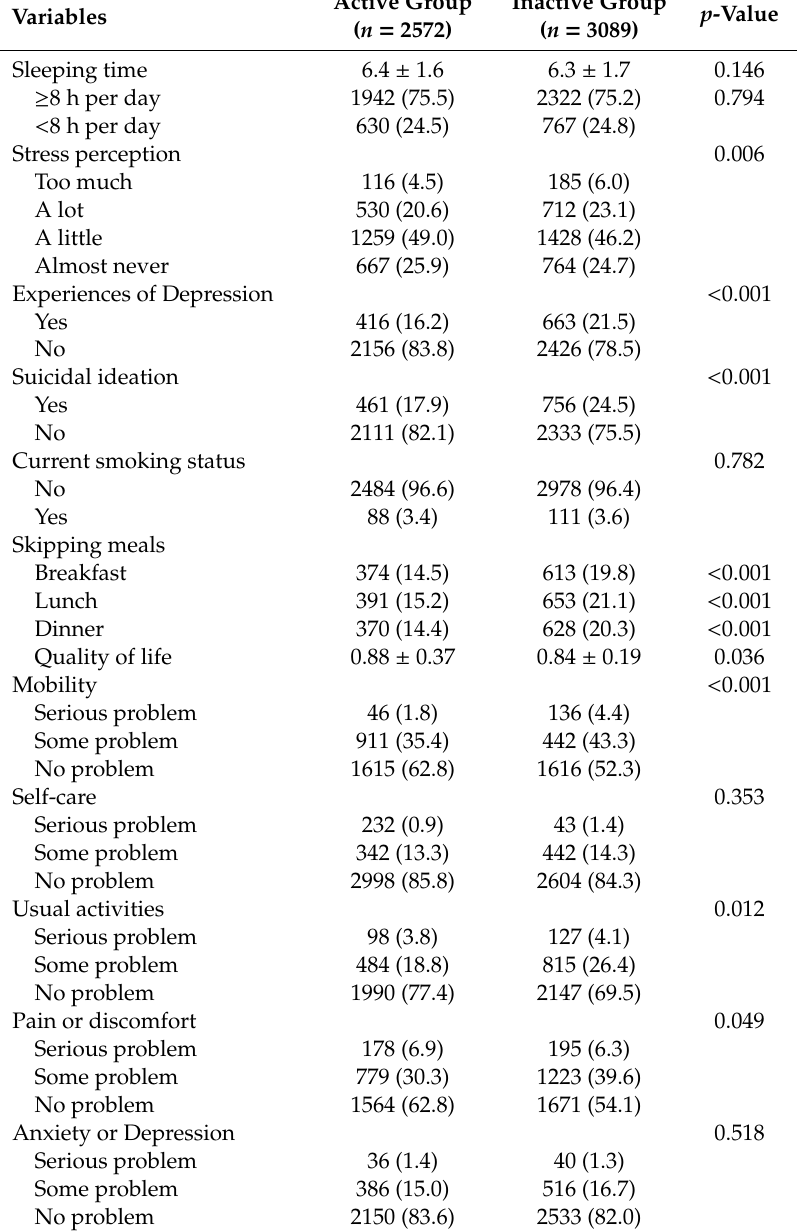
Table 3. Lifestyle and quality of life according to physical